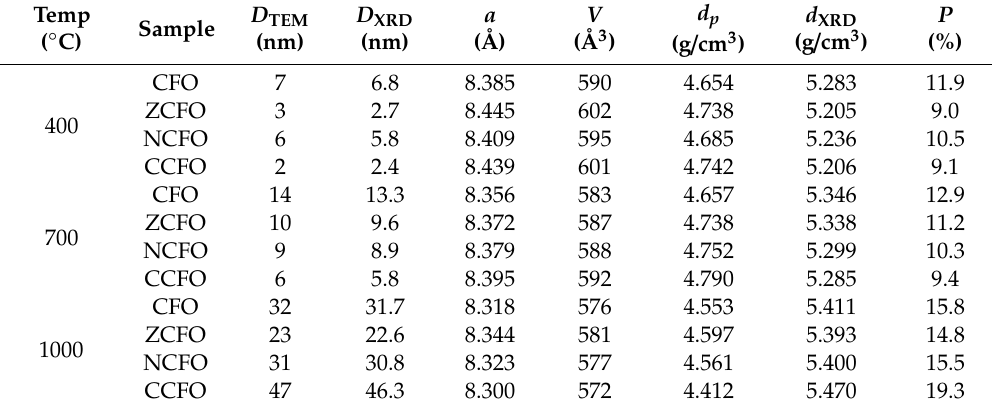
Table 1. Particle size ( D TEM ), crystallite size ( D XRD ), lattice constant ( a ), unit cell volume ( V ), physical density ( d p ), X-ray density ( d XRD ), and porosity ( P ) of CFO, ZCFO, NCFO, and